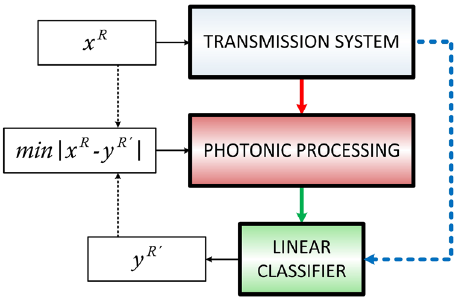
Figure 4: Block diagram of data recovery with photonic processing after optical transmission. The data stream x is encoded with data rate R and sent for optical transmission. The received signal after transmission is introduced at the photonic processing system (red arrow). The obtained signal response is used to train a linear classi fi er (green arrow) that predicts the data stream y . In case that the photonic processing introduces speed penalty, the predicted data stream is obtained with a slower data rate R ´. The minimization of the error | x – y | is obtained by parameter optimization of the photonic processing. The fi nal performance is commonly benchmarked to the performance of the same classi fi er trained by the received signal from transmission (blue